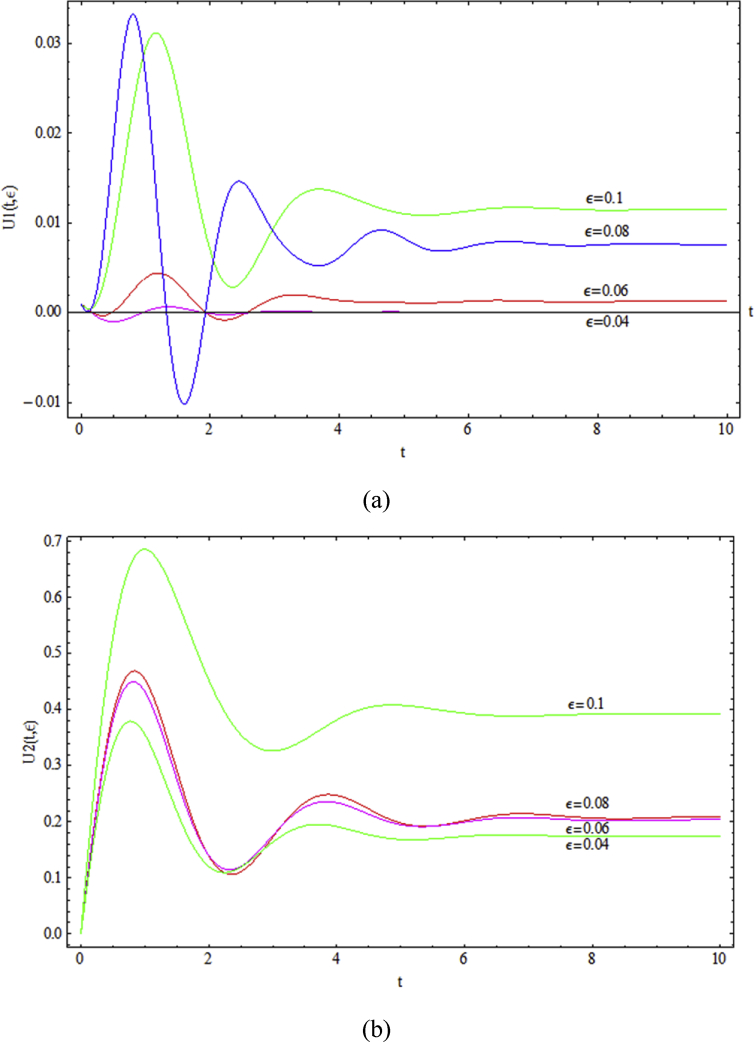
Transient behavior of a) U1 and b) U2, for various ε with We = 0.15, Δp = -1, ζ = 0.2 and Re = 0.2.